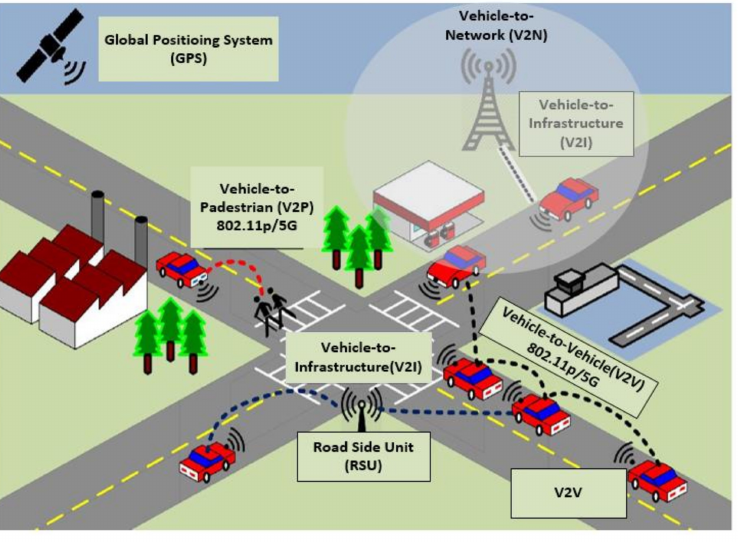
Figure 1. Vehicular communication scenarios in an ITS